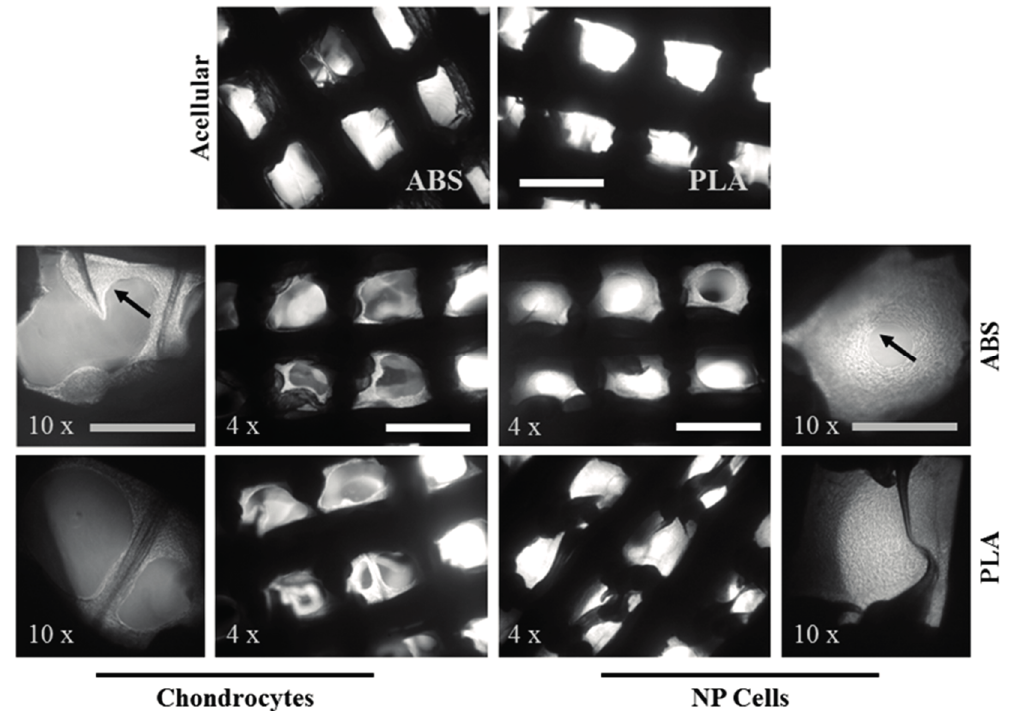
Figure 3. Cell ingrowth on ABS and PLA scaffolds. Representative phase contrast images of cell-seeded scaffolds at 4× and 10× magnification after 21 days of culture ( n = 4). Black arrows indicate cell growth and neo-tissue deposition. White scale bar represents 1 mm; grey scale bar represents 500